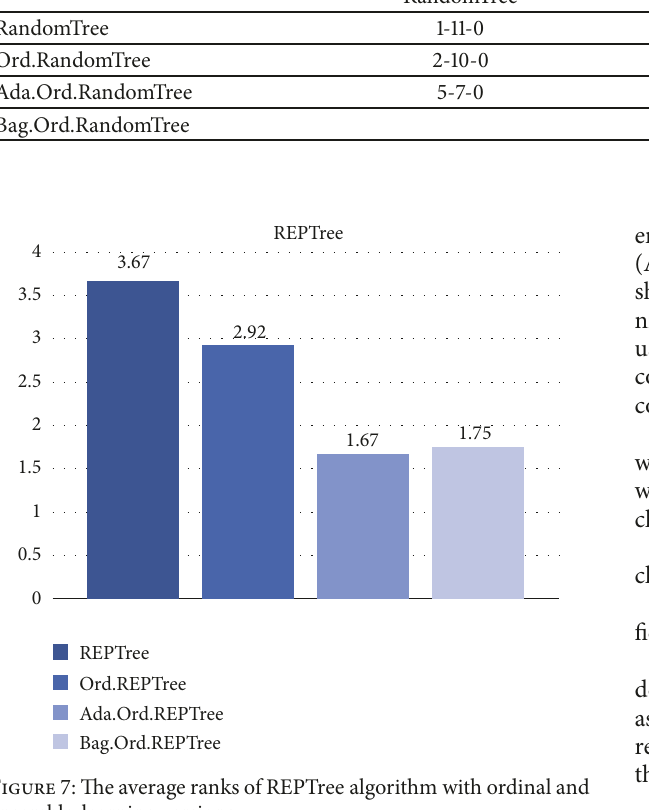
Table 7: The pairwise combinations of the RandomTree algorithm with ordinal and ensemble learning versions. Bag.Ord.